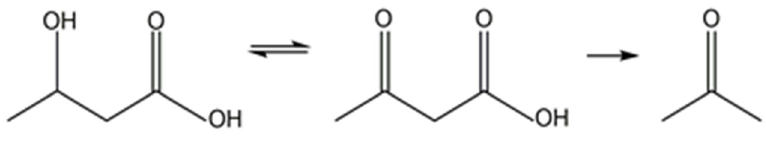
Figure 1. Structure of ketone bodies.